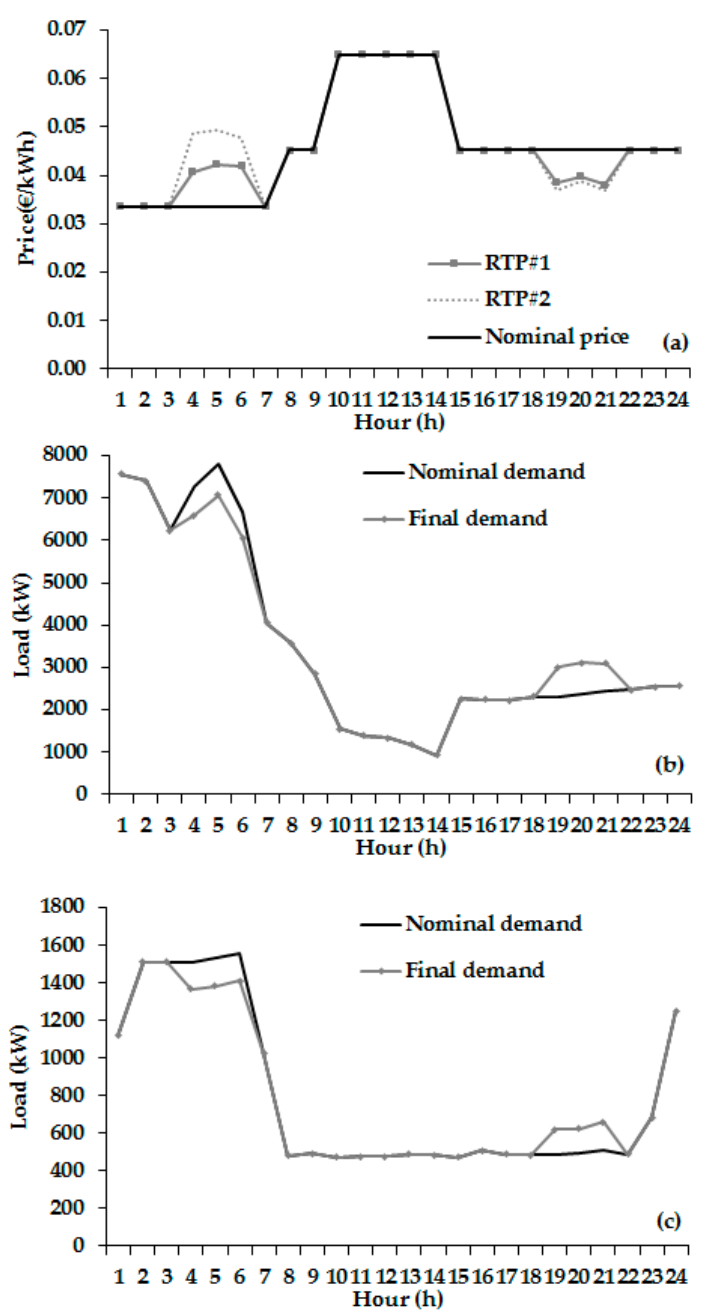
Figure 18. LS objective results with exponential DR model: ( a ) Nominal price and RTP; ( b ) nominal and final demand of consumer 1 and ( c ) nominal and final demand of consumer 2.